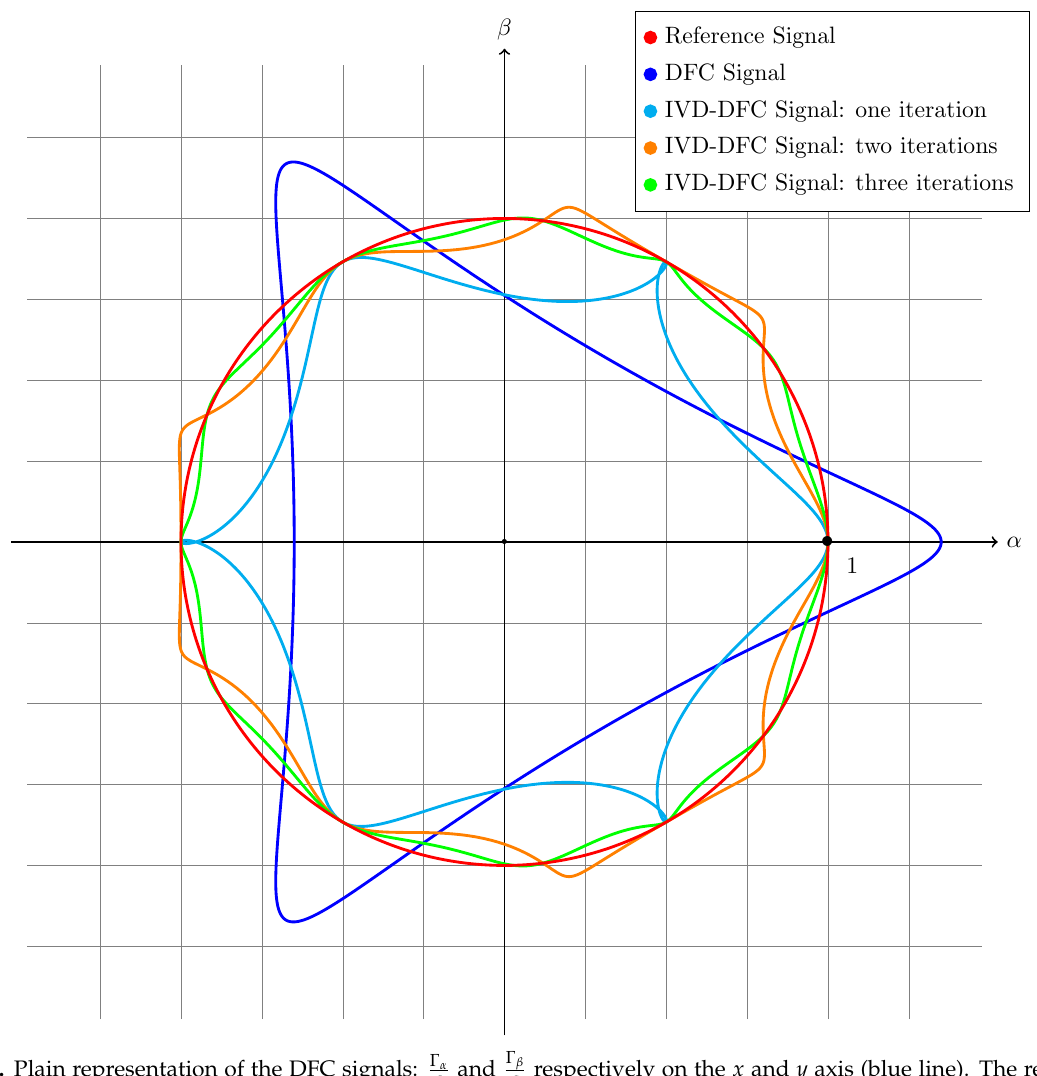
Figure 8. Plain representation of the DFC signals: represents the signals for the case b = 0 and is taken as reference. The other lines are referring to certain numbers of iterations for the IVD-DFC algorithm (case with p =